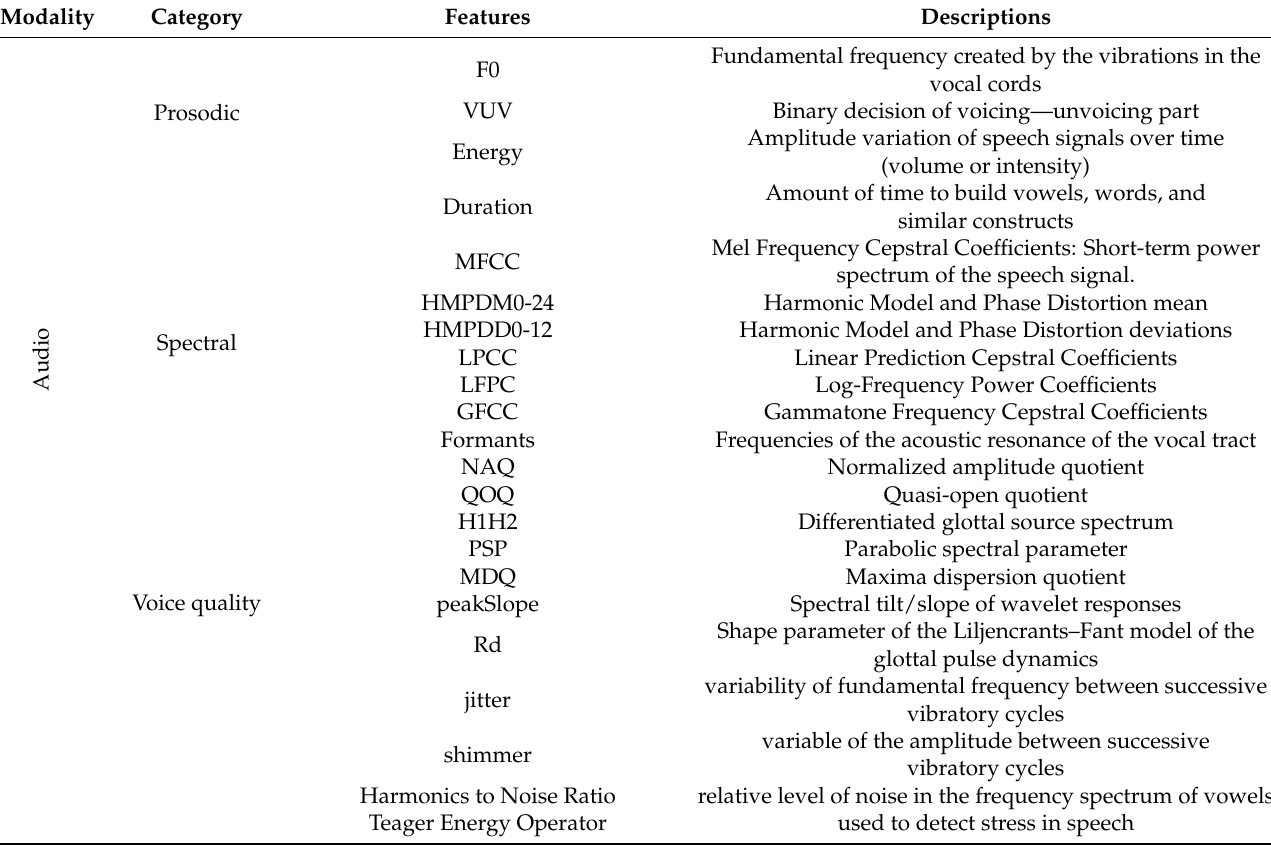
Table 3. The details of the extracted